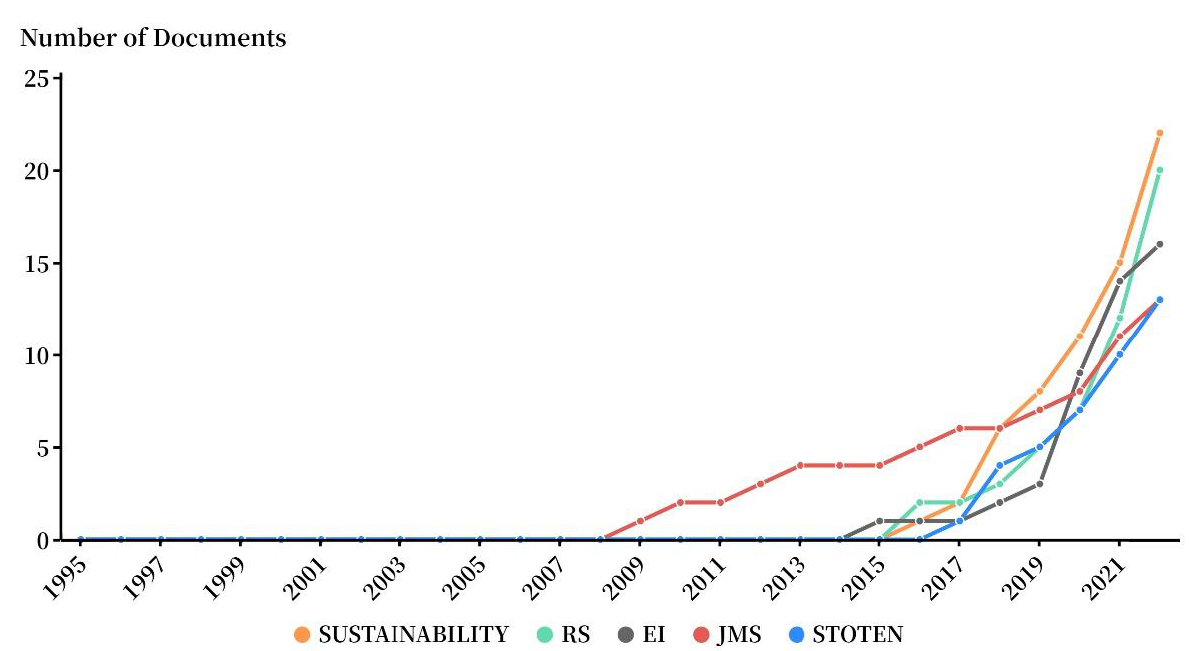
Figure 4. Affiliations’ production over time for investigating the ecological and environmental effects of land use and cover changes (LUCC) on the Qinghai-Tibetan Plateau (QTP). Note: RS = Remote Sensing , EI = Ecological Indicators , JMS = Journal of Mountain Science , STOTEN = Science of the Total Environment , JEM = Journal of Environmental Management .